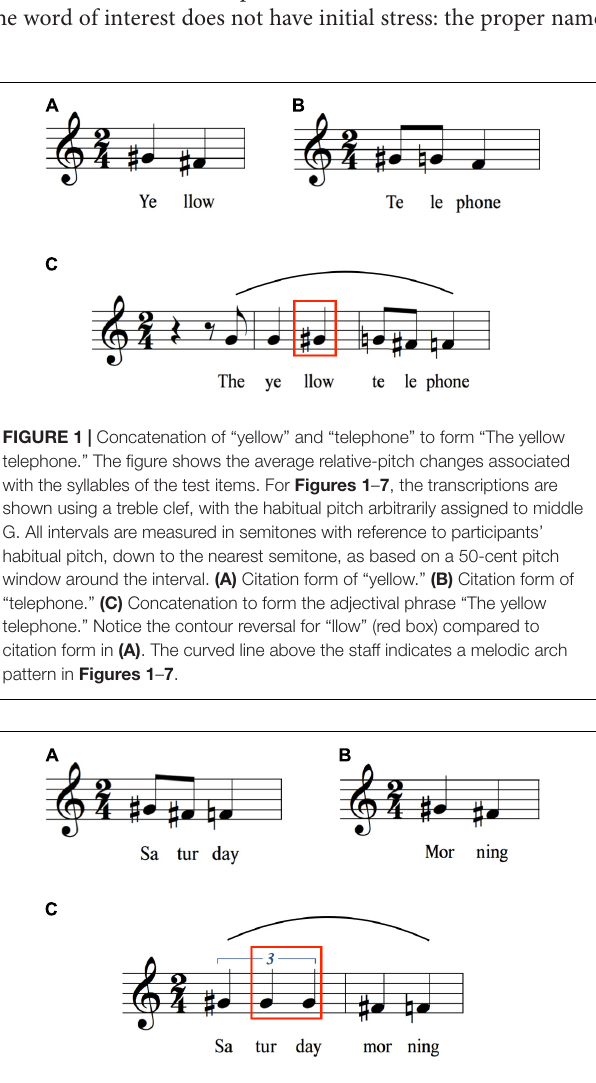
FIGURE 2 | Concatenation of “Saturday” and “morning” to form “Saturday morning”. (A) Citation form of “Saturday.” (B) Citation form of “morning.” (C) Concatenation to form the phrase “Saturday morning.” Notice the contour reversal for “tur” and “day” (red box) compared to the citation form in (A) .